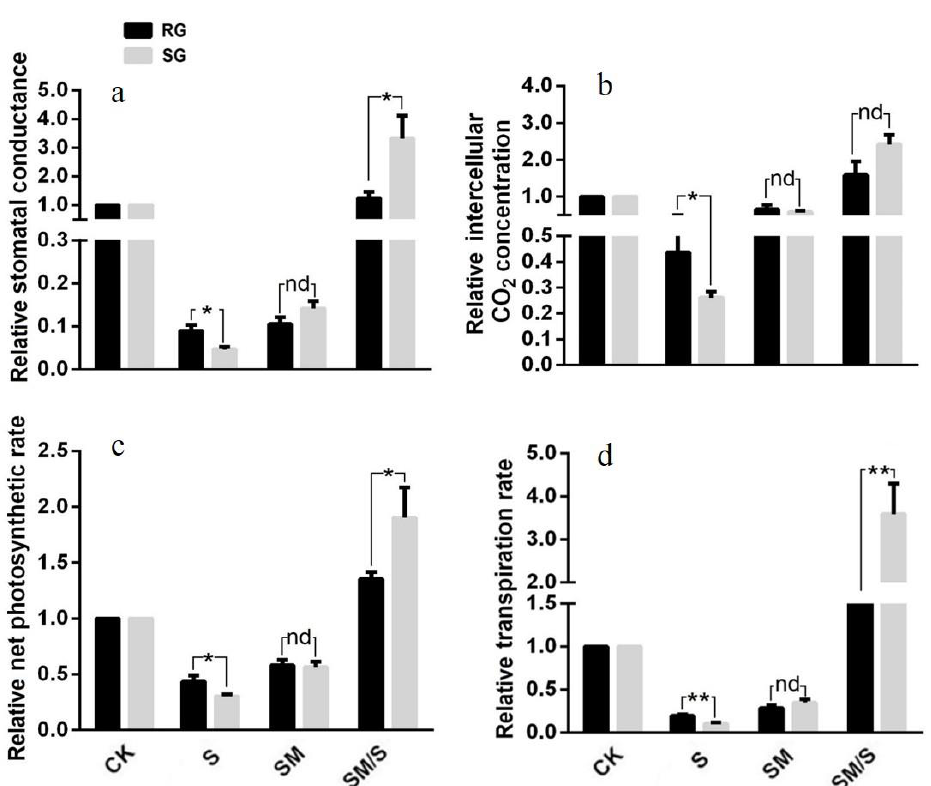
Figure 4. Comparison of gas exchange parameters, including relative stomatal conductance ( a ), relative intercellular CO 2 concentration ( b ), relative net photosynthetic rate ( c ), and relative transpiration rate ( d ) between salt resistant and salt sensitive tomato seedlings under salt stress. All the indices normalized to CK. RG: salt-resistant genotype; SG: salt-sensitive genotype; CK: 1/2 Garden nutrient solution of Japan (GNSJ) + spraying distilled water; M: GNSJ + spraying 100 µ M melatonin; S: GNSJ-NaCl (containing 200 mM NaCl) + spraying distilled water; SM: GNSJ-NaCl (containing 200 mM NaCl) + spraying 100 µ M melatonin. The asterisk indicates significant difference detected by Student’s t -test ( p < 0.05 marked with * and p < 0.01 marked with **). nd: no difference. Mean ± SE were given (n = 3, biological replications).